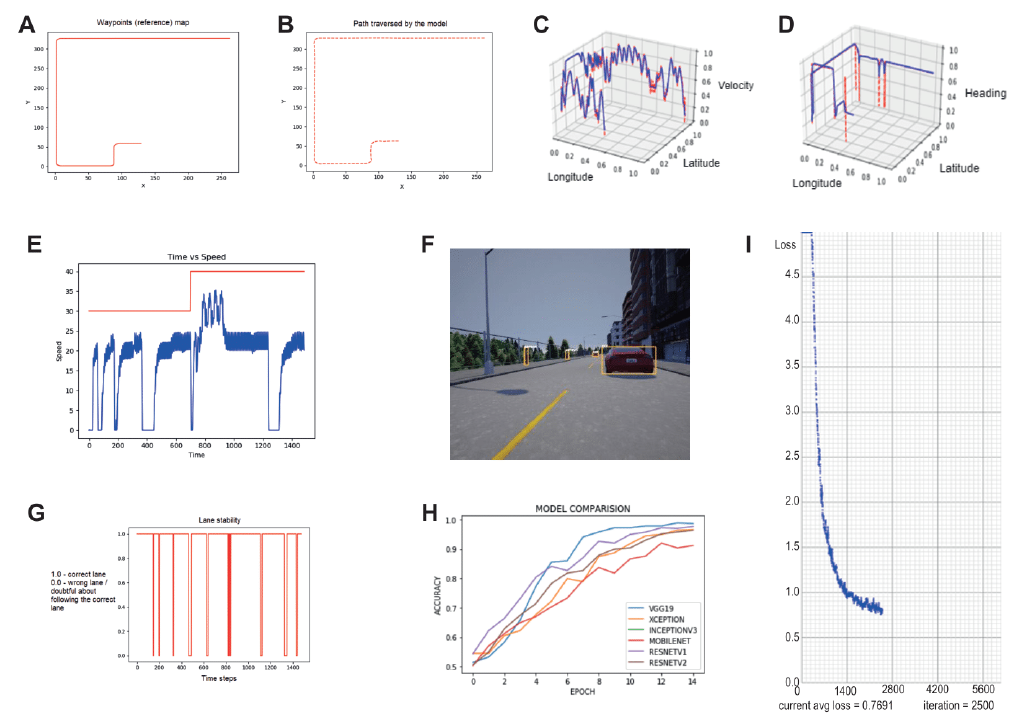
Figure 10. Overview of the testing and the corresponding results. The reference path is shown in ( A ) and the traversed path is shown in ( B ). The velocity and heading predictors have been shown in ( C ) and ( D ), respectively. The effect of using a PID controller in the designed environment is shown in ( E ) (max speed limited to 30 kmph). The output of the object detection is shown in ( F ) and the lane stability graph in ( G ). The accuracies of the different machine learning models are shown in ( H ) with the average loss of the models for custom object detection in ( I